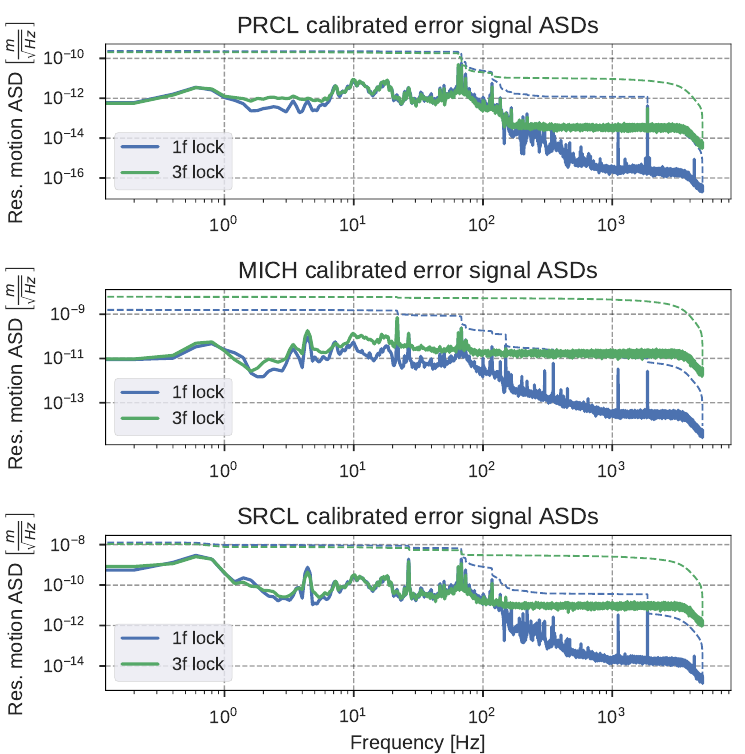
Figure 3. Experimental comparison between “1f” and “3f” error signals used to lock the DRMI. In particular, the comparison is between B2 6MHz and B2 18MHz for PRCL, and between B2 56MHz and B2 169MHz for SRCL and MICH. One can easily note that in all three cases, a flat shot noise dominates the spectrum above (cid:39) 100Hz in the “3f” signals. The plotted data has been acquired during the pre-O4 commissioning period, with 33 W of input